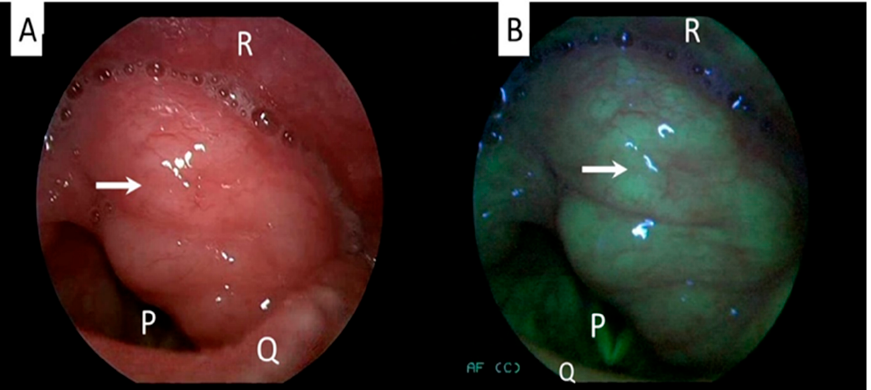
Figure 2. Laryngeal examination of a patient with benign laryngeal tumor showing no changes in the mucosa between white-light ( A ) and autofluorescence mode ( B ). Arrow indicates the tumor. Structure P: vocal cord/glottic, Q: epiglottis, R: posterior pharyngeal wall (Figure is from author’s own